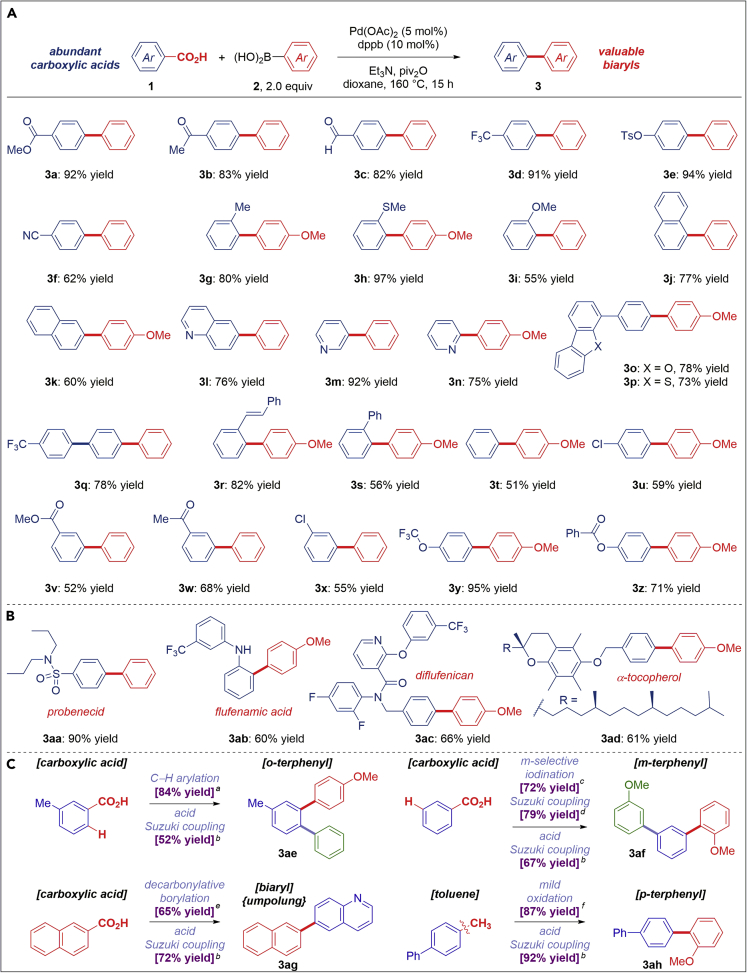
Scope of the Decarbonylative Suzuki-Miyaura Cross-Coupling of Carboxylic Acids: Carboxylic Acid Scope(A) Scope of carboxylic acids.(B) Late-stage functionalization.(C) Sequential cross-coupling.Conditions: Carboxylic acid (1.0 equiv.), Ar–B(OH)2 (2.0 equiv.), Pd(OAc)2 (5 mol %), dppb (10 mol%), Et3N (1.5 equiv.), piv2O (1.5 equiv.), H3BO3 (1.5 equiv.), dioxane, 160°C, 15 h. dppb, 1,4-bis(diphenylphosphino)butane; piv, pivaloyl.